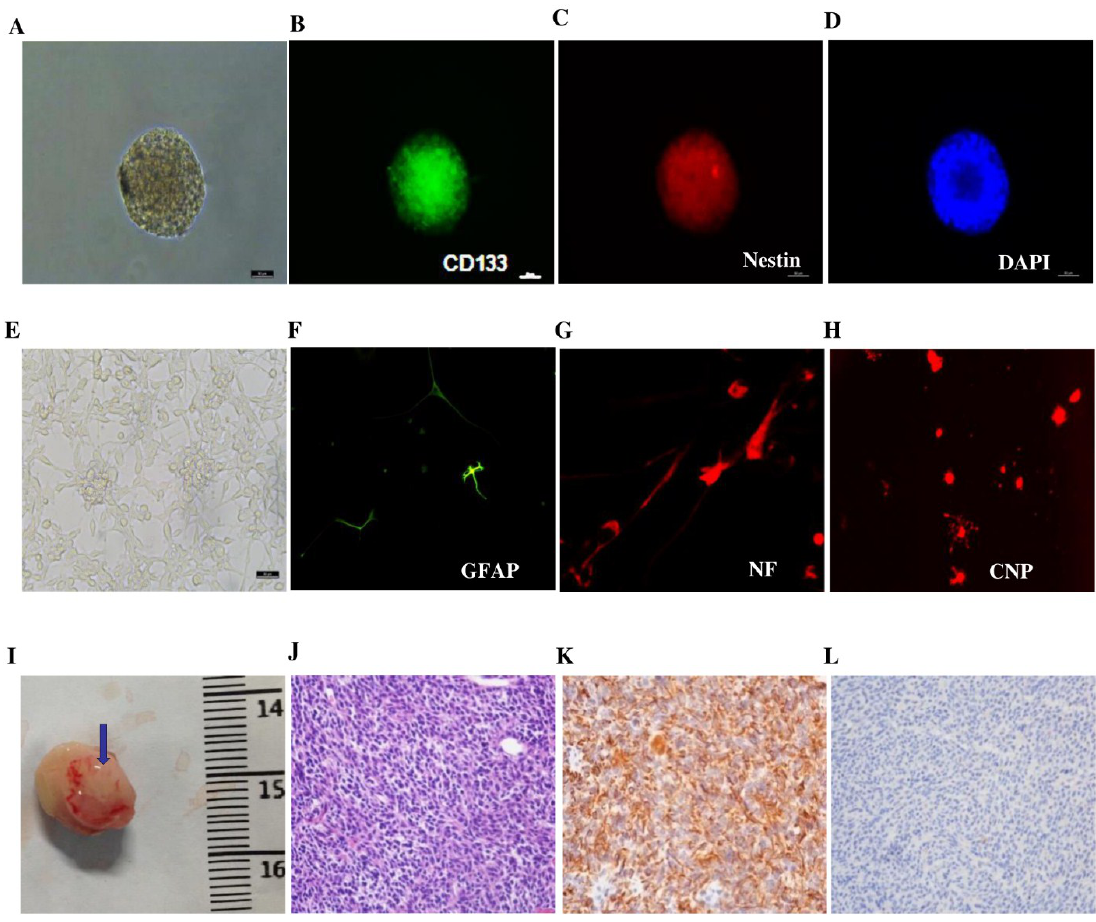
Figure 1. Determination of GICs (412) in vitro and in vivo . ( A ) Suspended cells formed the self-renewing spheres in stem cell conditioned culture medium (100×); ( B ) Immunofluorescent staining of single suspended cells showed CD133-positive staining (200×); ( C ) Immunofluorescent staining of single suspended cells showed Nestin-positive staining (200×); ( D ) Immunofluorescent staining of DAPI (200×); ( E ) Morphology of serum-induced differentiation of GICs under a microscope (100×); ( F ) Immunofluorescent staining in differentiated GICs showed GFAP-positive staining (200×); ( G ) Immunofluorescent staining in differentiated GICs showed NF-positive staining (200×); ( H ) Immunofluorescent staining in differentiated GICs showed CNP-positive staining (200×); ( I ) The representative image of GIC tumorigenesis in NOD/SCID mice; the tumor is indicated by the blue arrow; ( J ) H & E staining showed the brain xenograft as GBM (200×); ( K ) Immunohistochemical staining in the xenograft section presented high expression levels of Nestin (200×); ( L ) Immunohistochemical staining of xenograft samples presented acicular expression of GFAP